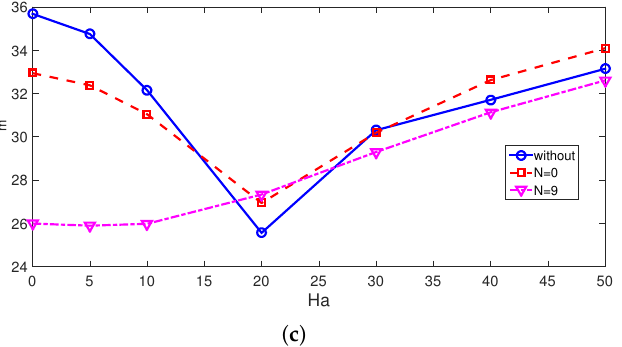
Figure 9. Impacts of MGF strength on local ( a , b ) and average ( c ) Nu variations by using different PP configurations (Re = 800, Ca = 10 − 5 , Da = 10 − 2 ).